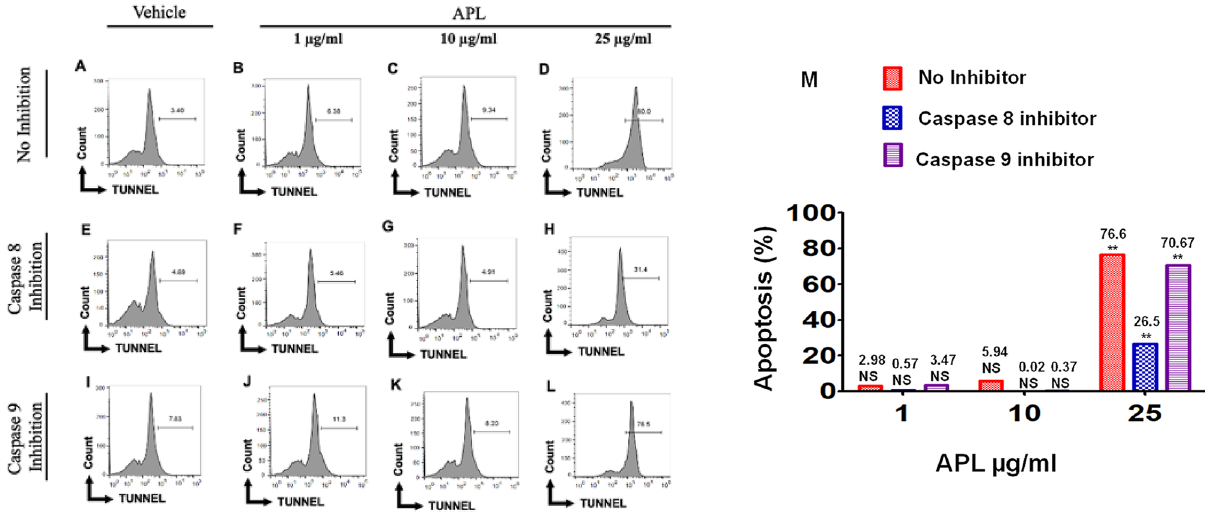
Figure 7. Role of caspase 8 and 9 in apoptosis induction of B16 melanoma cells: This was determined by TUNNEL assay. Cells were treated at different concentrations with APL ( Psiadia lithospermifolia ) and vehicle or in the presence of inhibitors of caspase 8 and 9. ( A – D ) represent treatment without any inhibitors of caspases where ( A ) (vehicle DMSO), ( B ) (1 µg/ml), ( C ) (10 µg/ml), ( D ) (25 µg/ml) of APL. ( E – H ) represent treatment with APL in presence of caspase 8 inhibitor. ( E ) (vehicle DMSO), ( F ) (1 µg/ml), ( G ) (10 µg/ml), ( H ) (25 µg/ ml) of APL extract. ( I – L ) represent treatment with APL in presence of caspase 9 inhibitor. ( I ) (vehicle DMSO), ( J ) (1 µg/ml), ( K ) (10 µg/ml), ( L ) (25 µg/ml) of APL extract. The data presented are representative of three independent experiments. Bar chart (M) shows quantitative data of average of two independent flow